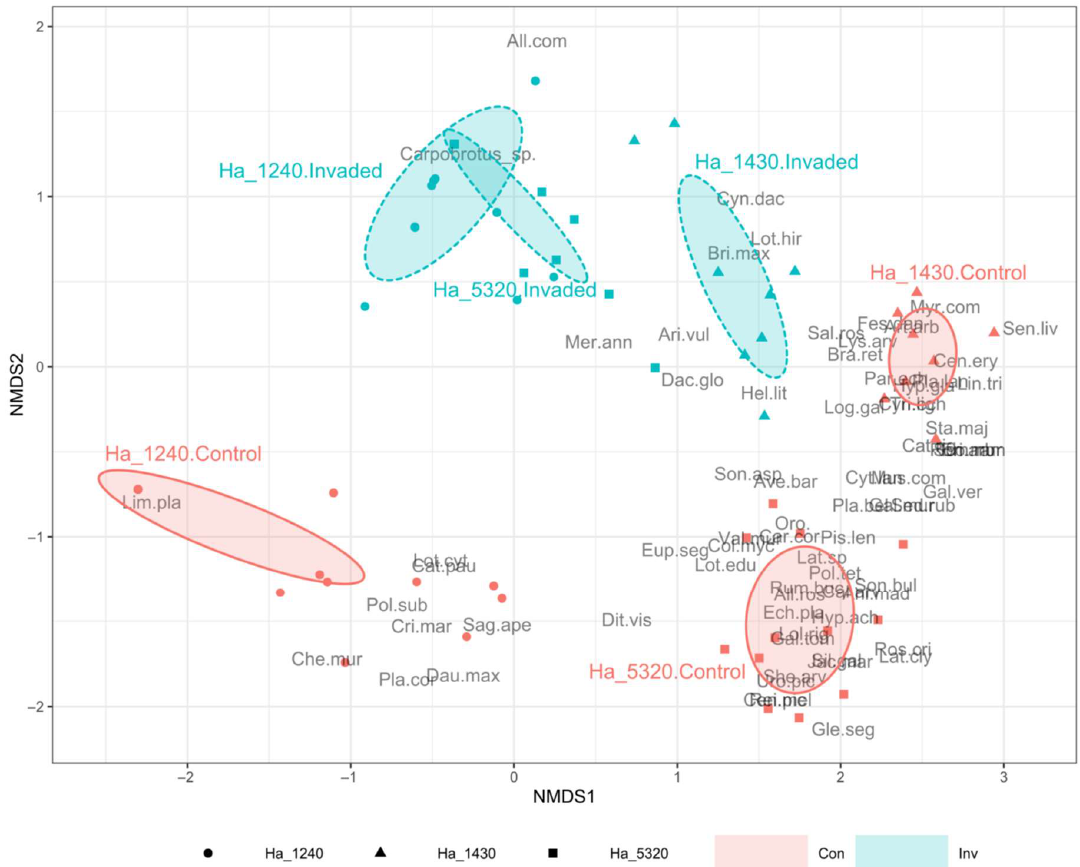
Figure 3. Non-metric multidimensional scaling (NMDS) ordination plot based on Bray–Curtis dissimilarities of the 88 sampled plots. Plots are grouped according to N2000 habitat and invasion status (Control plots vs. Invaded plots). Ellipses represent the standard deviation of sampled plot positions. N2000 habitat codes: Ha_1240 (circles) = vegetated sea cliffs of the Mediterranean coasts with endemic Limonium spp.; Ha_1430 (triangles) = Halo-nitrophilous scrubs ( Pegano - Salsoletea ) and Ha_5320 (squares) = Low formations of Euphorbia close to cliffs. See Supplementary Table S4 for plant full names. Invasion Status codes: Con (red)= Control plots; Inv (blue) = Invaded plots.